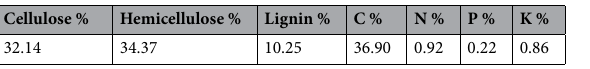
Table 1. Initial component content of corn